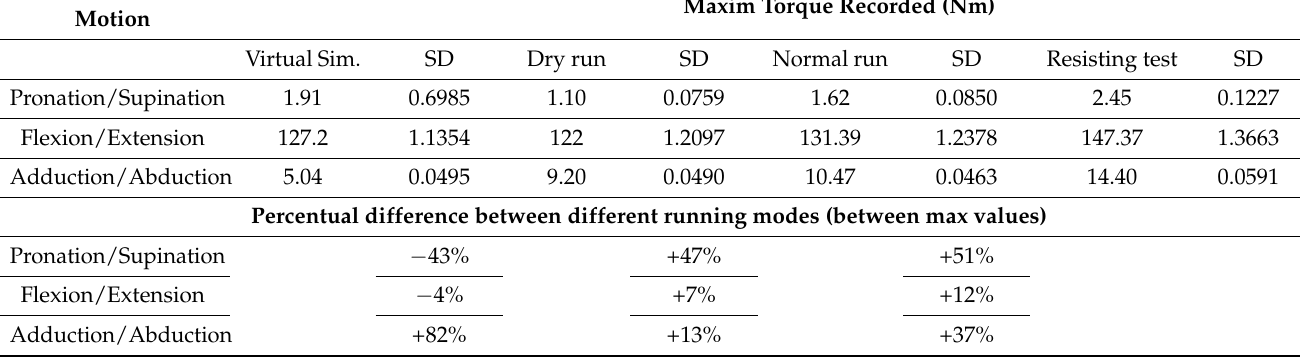
Figure 15. Graphical representation of the experimental tests’ results. Table 3. Torque analysis Table 3. Torque analysis results.